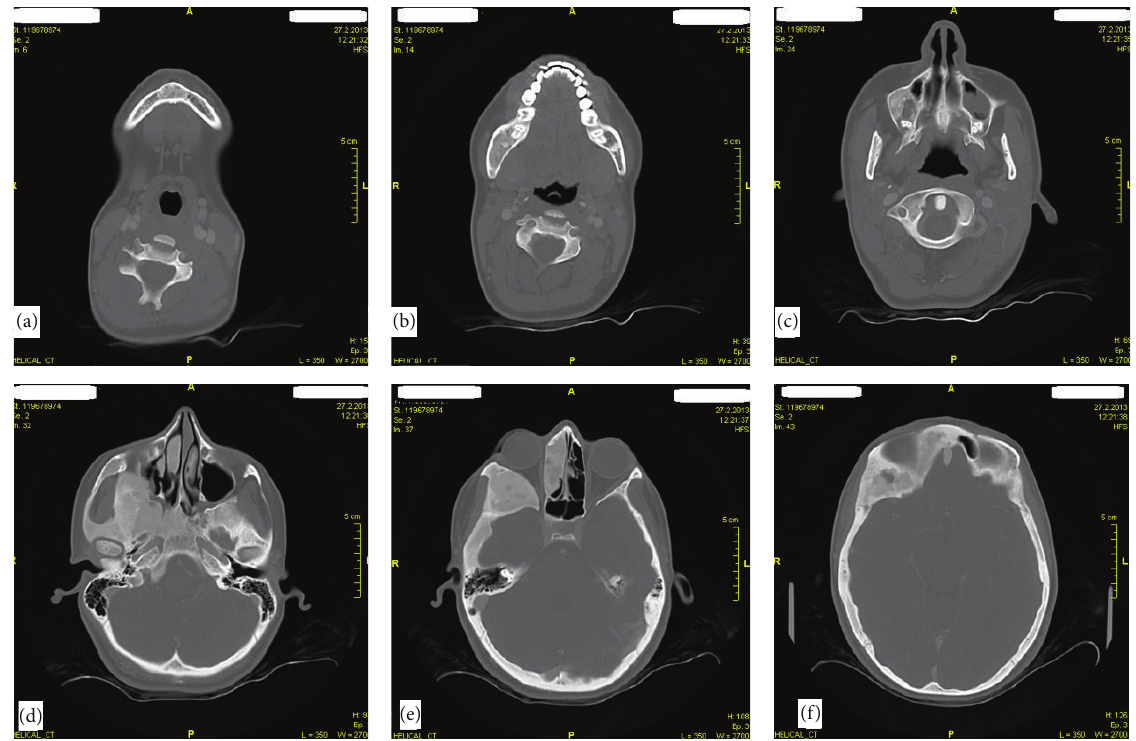
Figure 3: (a), (b), (c), (d), (e), (f) Axial CT scans (bone window) showing multiple bone lesions involving skull base and facial